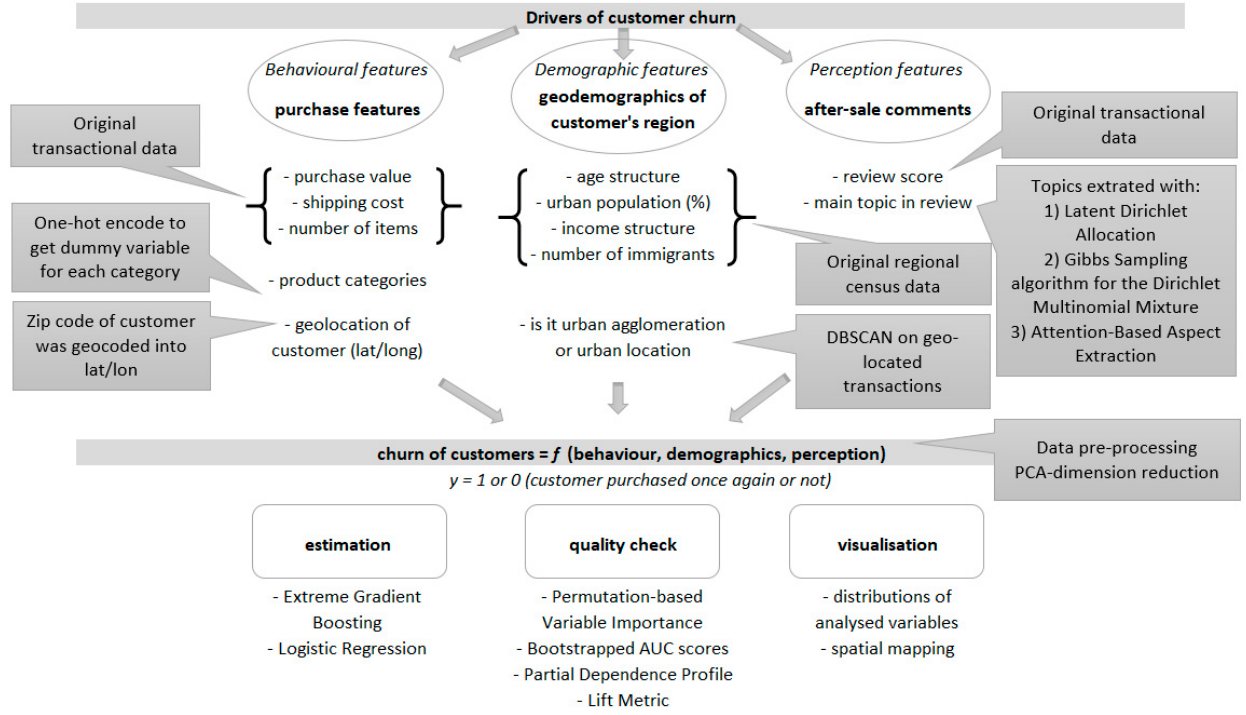
Figure 1. Flowchart of analytic